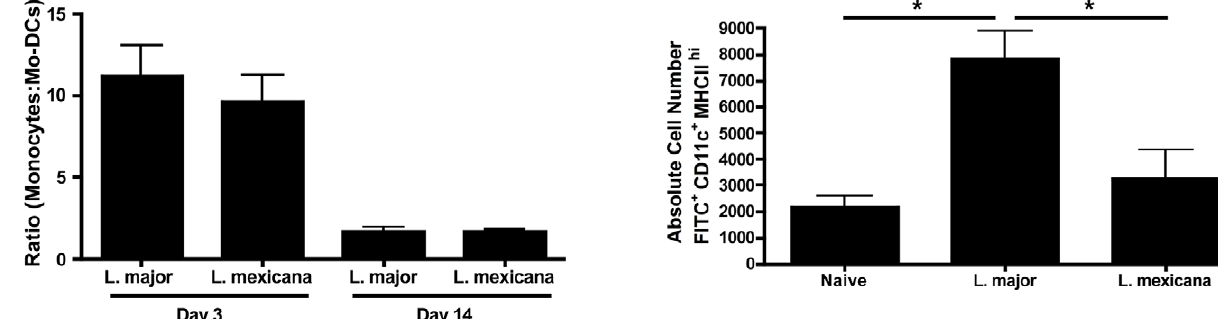
Figure 4. Fewer FITC + endogenous mo-DCs migrate to the dLN during L.mexicana infection compared to L.major . C57BL/6 mice were infected as above for two weeks. FITC isomer was applied to the ears of naı¨ve, L. major or L. mexicana infected mice on day 14 and dLNs were harvested and processed forty-eight hours later. FITC + MHCII hi CD11c + cells were enumerated in the dLNs. These cells are previously gated on live, singlets that are CD11b hi . The results expressed are the mean number of cells ( 6 SE) of 3 mice per group. The results are representative of two experiments. *significantly different (p , 0.05) between indicated